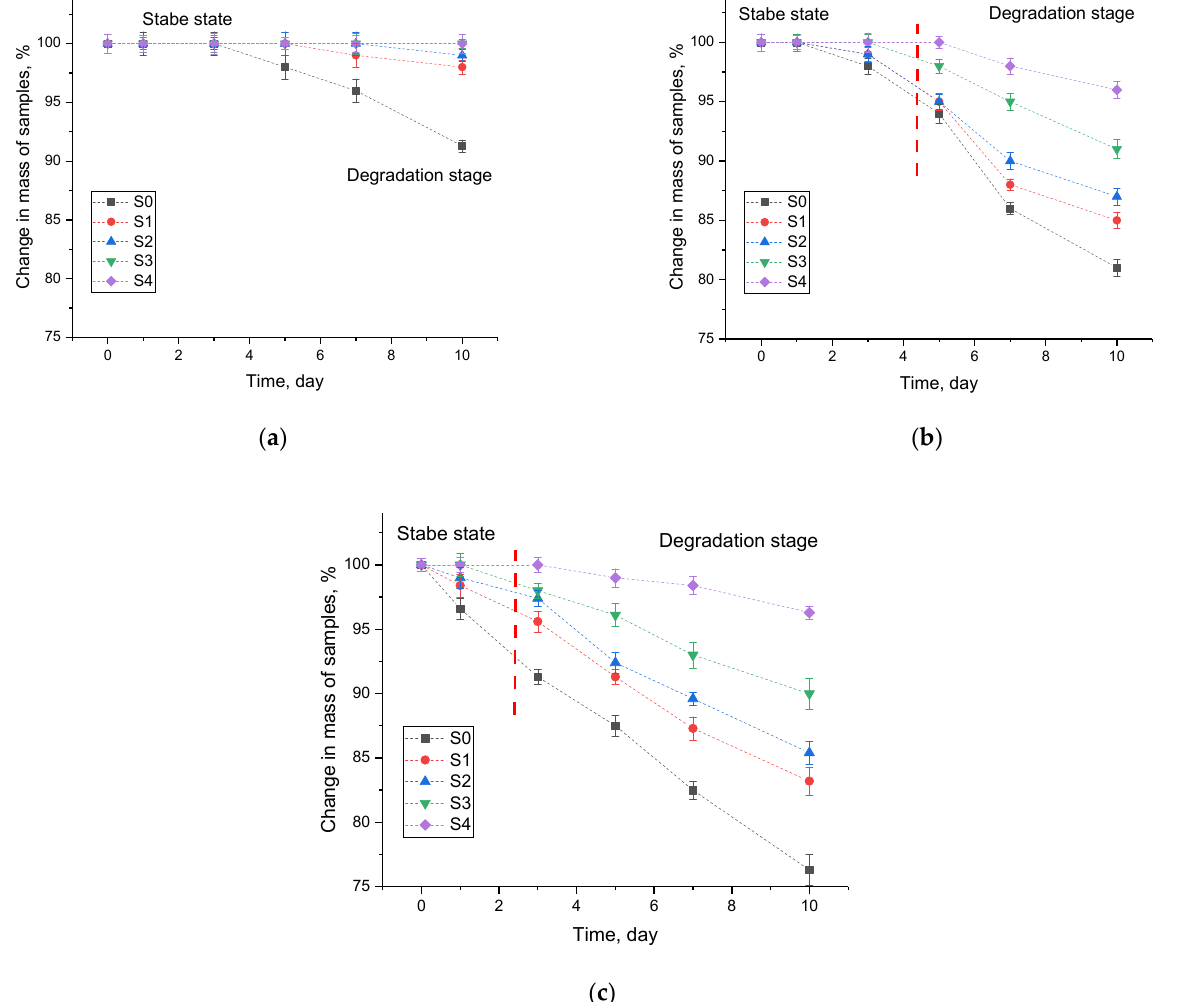
Figure 11. Changes in the masses of the samples as a result of corrosion tests at different temperatures of the aqueous solution: ( a ) T water = 25 °C; ( b ) T water = 35 °C; ( c ) T water = 42 °C. In the case of a solution temperature of T water = 25 °C, the most pronounced degradation processes associated with a change in mass were observed for samples of Fe 3 O 4 NPs, for which the maximum change in mass after 10 days of being in an aqueous solution was 7–8%. For samples of nanoparticles annealed at a temperature of 600 °С Fe 3 O 4 NPs and Fe 2 O 3 @Au NPs, the most noticeable mass changes were observed only after 5 days of being in an aqueous solution, and after 10 days, the mass change was no more than 1–2%, which also indicates a fairly high degradation resistance. The decrease in the mass of samples indicates that when nanoparticles are in aqueous solution, the main corrosion mechanisms are associated with the processes of oxidation and subsequent decomposition of nanoparticles, and their decay into components. For samples of Fe 3 O 4 @GdFeO 3 NPs and Fe 2 O 3 @NdFeO 3 NPs, no change in mass was observed after 10 days of being in an aqueous solution at a temperature of 25 °С, which indicates a sufficiently high resistance of nanoparticles to degradation processes as a result of corrosion (see the results of Figure 12).